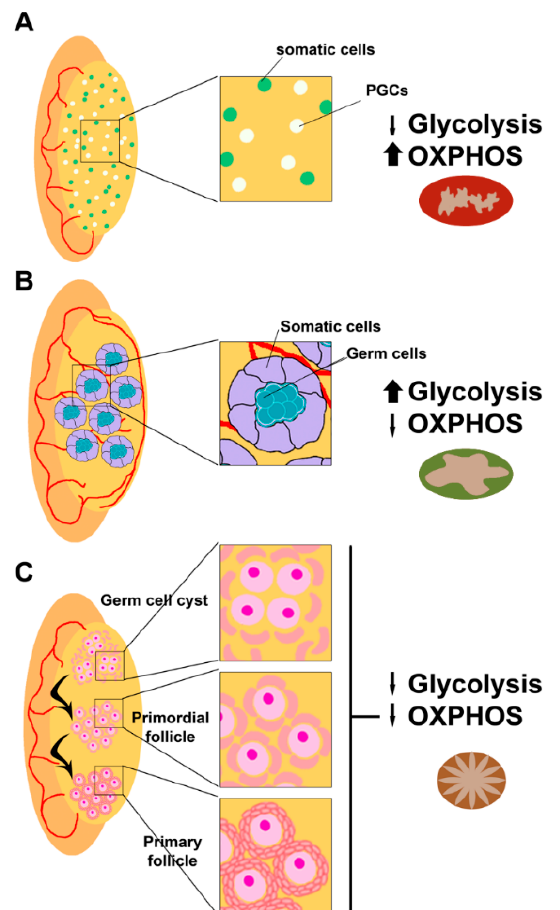
Figure 2. Mitochondrial requirements during fetal gonad development. ( A ) After migration to the genital ridge, primordial germ cells (PGCs in white) colonize the gonadal ridges, and start proliferating and specifying with the help of gonadal somatic cells (in pale green). At that point, mitochondria present at PGCs present a condensed form that corresponds to their metabolic requirement of ATP provided by OXPHOS (colored as red). Sexual commitment depends on the gonadal environment and PGCs commit to spermatogenesis ( B ) in a fetal testis or oogenesis ( C ) in a fetal ovary. ( B ) In a fetal testis, germ cells proliferate to form spermatogonia, which are glycolytic cells presenting orthodox mitochondria (colored as green). At this moment, signals provided from somatic cells of the developing testis block the meiotic entrance of spermatogonia. ( C ) In a fetal ovary, germ cells commit to oogenesis in the absence of inhibiting signals. PGCs proliferate and differentiate to oogonia and undergo meiosis to form primary oocytes. At that moment, the metabolic requirements are low and mitochondria present in those primary oocytes are transcriptionally and bioenergetically silent (quiescent state colored as brown). ATP is almost entirely provided by somatic cells surrounding oogonia and primary